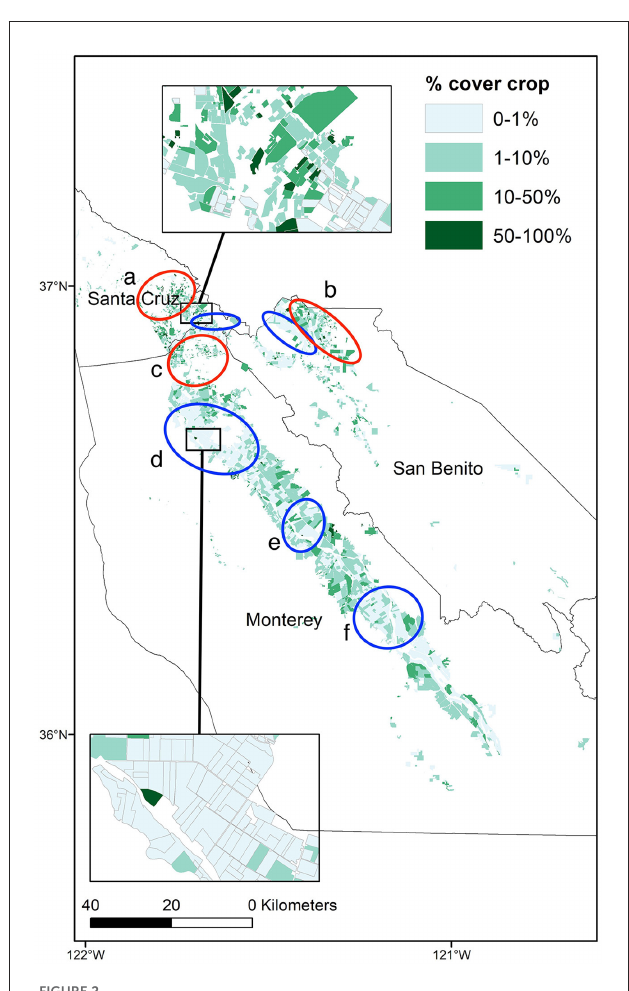
FIGURE2 Map of Monterey, San Benito, and Santa Cruz counties showing the percent area of each ranch covered by cover crops. Inset maps show areas of higher (Santa Cruz) and lower (Monterey) hedgerow adoption. Red ovals indicate significant hotspots of hedgerow adoption while blue ovals indicate coldspots.